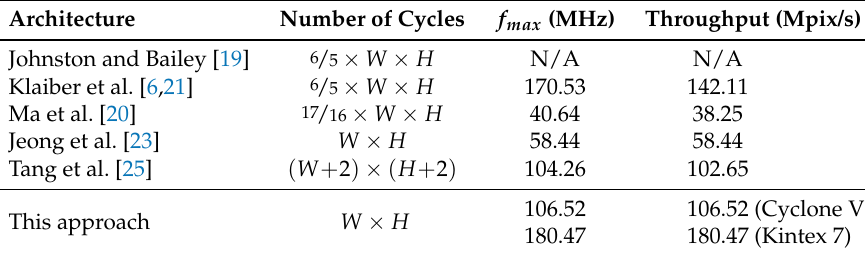
Table 5. Comparison of processing cycles for a W × H